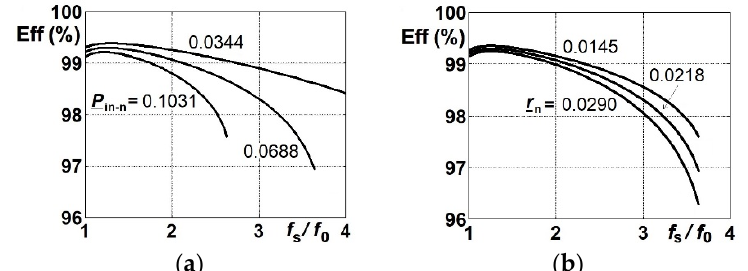
Figure 6. Efficiency of SCVD as a function of f S n = f S / f 0 : ( a ) for three values of P in-n = P in /( U 2 in / ρ ): 0.0344, 0.0688, and 0.1031 at r n = r / ρ = 0.0218, ( b ) for three values of r n = 0.0145, 0.0218, and 0.0290 at P in-n = 0.0688. Δ U D n = 0.006. Switching pattern P2.